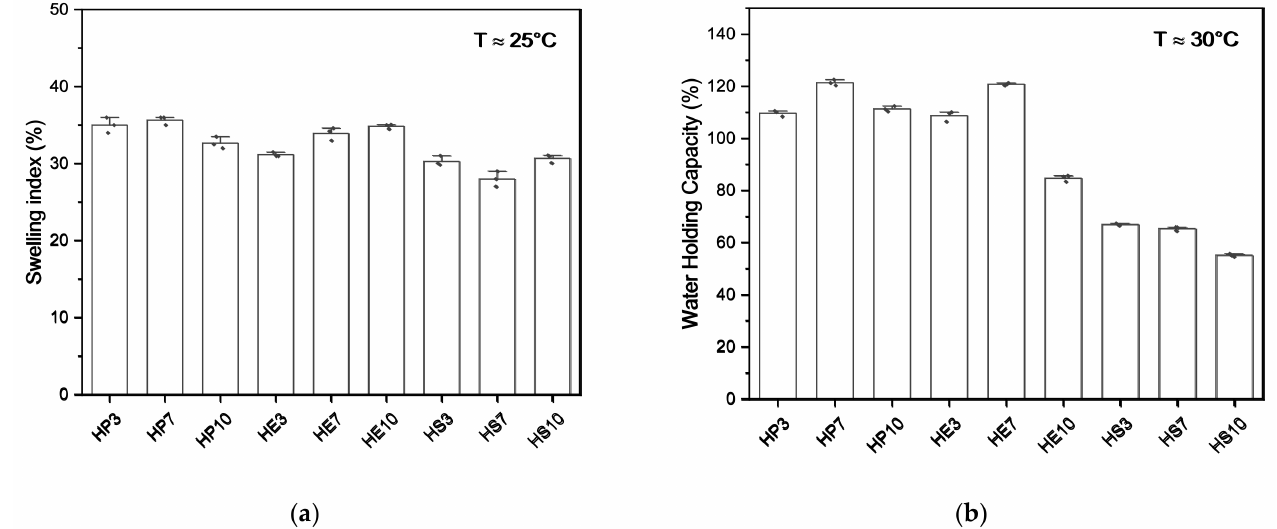
Figure 4. ( a ) Swelling index (SI) and ( b ) water holding capacity (WHC) of hydrocolloids from mango ( Mangifera indica ) var.